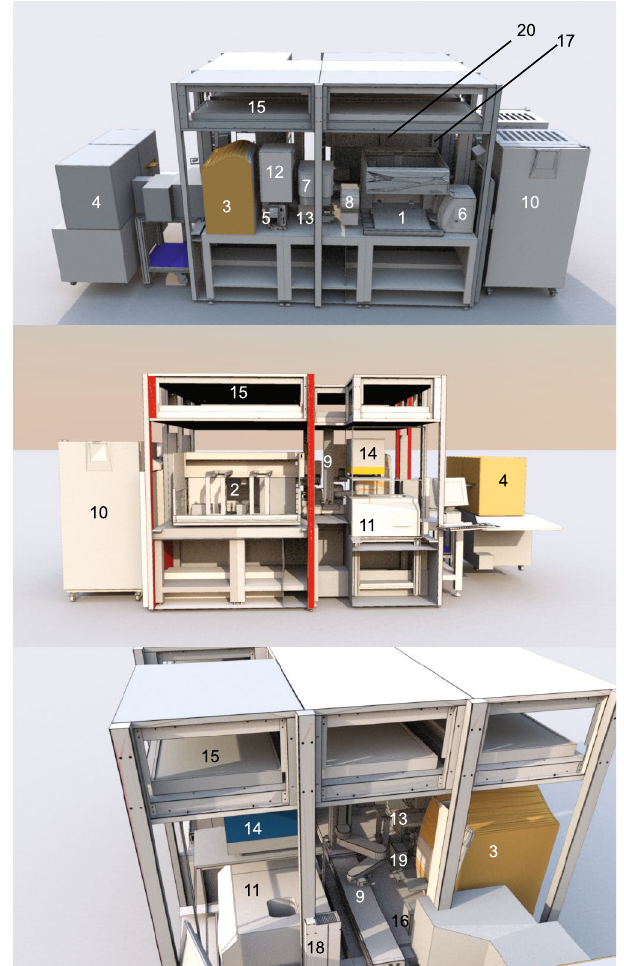
Figure 1. Schematic of the automated platform. ( 1 ) Liquid handler Biomek NX Span-8 including the plate shaker Shaking Peltier ALP and a tilting station Amplius (AIG) 3D Tilting ALP, ( 2 ) Liquid handler Biomek FXP (96- and 384-pipetting head including active wash-station and a BioShake 3000, ( 3 ) Acoustic droplet ejector Labcyte Echo550, ( 4 ) High content imager Yokogawa CV8000, ( 5 ) plate sealer Wasp, ( 6 ) Cell counter Vi-Cell XR12, ( 7 ) plate seal remover Nexus Xpeel, ( 8 ) Barcode printer and reader Scinomix Sci-Print MP2, ( 9 ) Precise SCARA robotic arm on rail, ( 10 ) 4 °C and 37 °C incubators Cytomat 24-C, ( 11 ) Sigma refrigerated centrifuge 6-16KR, ( 12 ) Tube de-capper Cap-it All, ( 13 ) Plate washer Biotek 405 LSHTV, ( 14 ) Multimode plate reader SpectraMax i3 Multi-Mode Platform and Minimax imager, ( 15 ) Custom made biosafety class 2 enclosure, ( 16 ) 2D-barcode reader Visionmate, ( 17 ) 4 deliiding modules, ( 18 ) 5 Tipbox labware feeders, ( 19 ) Regrip station, ( 20 ) 4 shelf labware